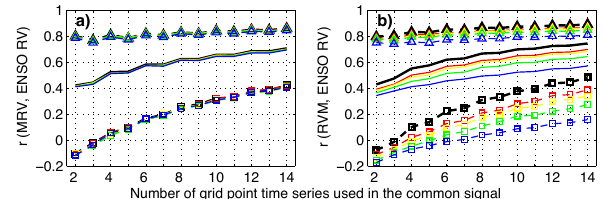
Figure 6: a) the 5% (dashed line with squares), 50% (solid line) and 95% (dashed lines with triangles) of the correlation coefficients calculated between the CM2.1 rainfall MRV and ENSO running variance, while b) displays the percentiles of correlation coefficients calculated between CM2.1 rainfall RVM and ENSO running variance. The black lines indicate those percentiles using data with no introduced dating errors, while the red, yellow, green and blue line respectively represent those percentiles using data with 1/5, 1/4, 1/3, 1/2 of the time series including an introduced dating error.